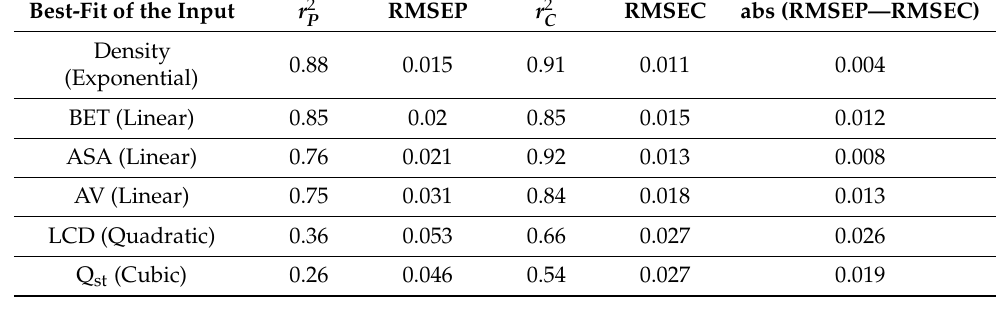
Table 5. Model performance measures for the best-fitting SLR models, developed using the calibration set and tested on the validation set. The values are in decreasing order of r 2 .